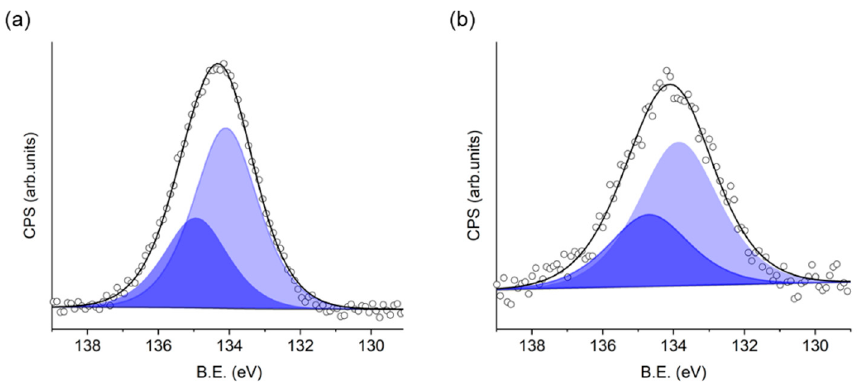
Figure 1. XPS P 2p spectra of 8 dropcasted on Au/mica: ( a ) as produced, ( b ) after 3 catalytic cycles. Empty circles represent the experimental data, black solid line represent the convolution of the fitted two spin orbit components (blue areas).